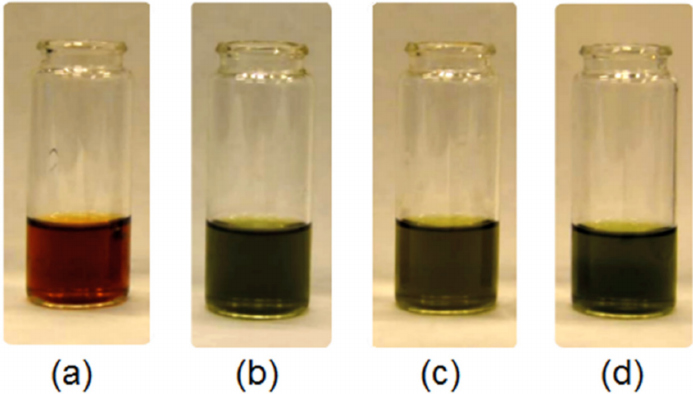
Figure 2. Photographs of the Kalanchoe pinnata extracts: ( a ) commercially available extract; ( b ) plant extract prepared using 50% ethanol solution; ( c ) plant extract prepared using 95% ethanol solution; ( d ) plant extract prepared using 95% ethanol solution and ultrasounds.